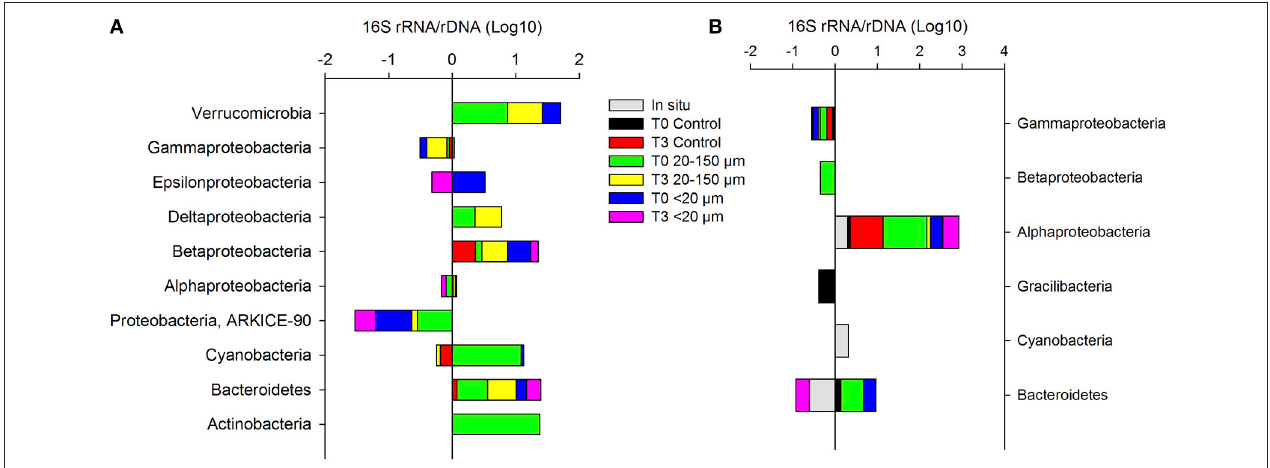
FIGURE 8 | The 16S rRNA/rDNA ratio at the initial and final incubation times (T 0 -T 3 ) for Phyla and Proteobacteria class in late summer (A) and spring (B)